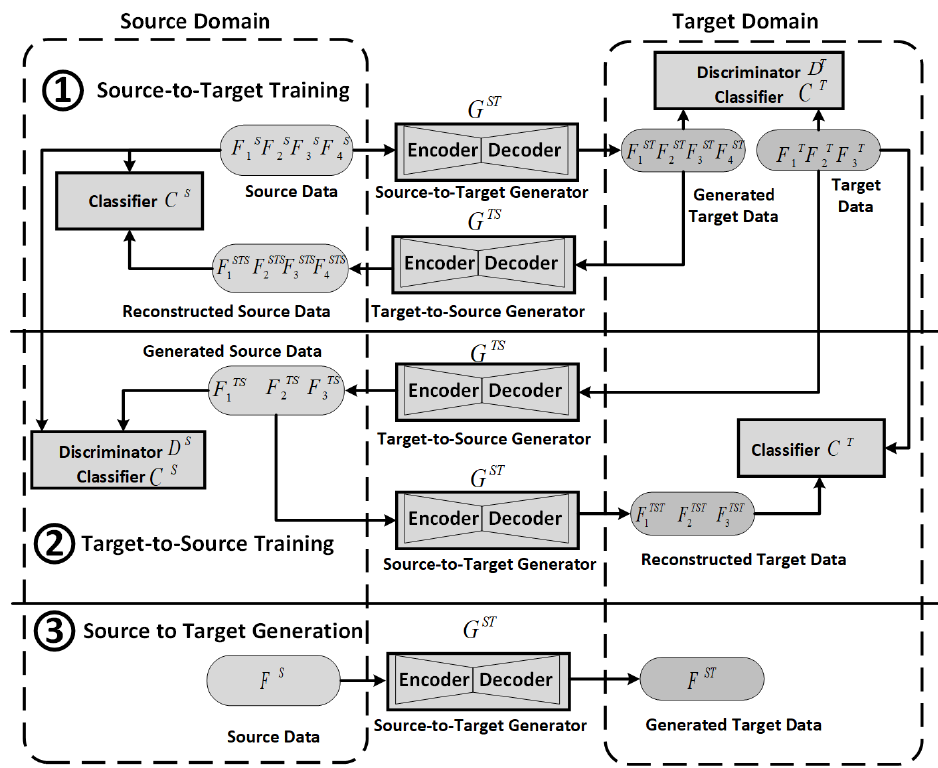
Figure 2. Architecture and working principles for the proposed